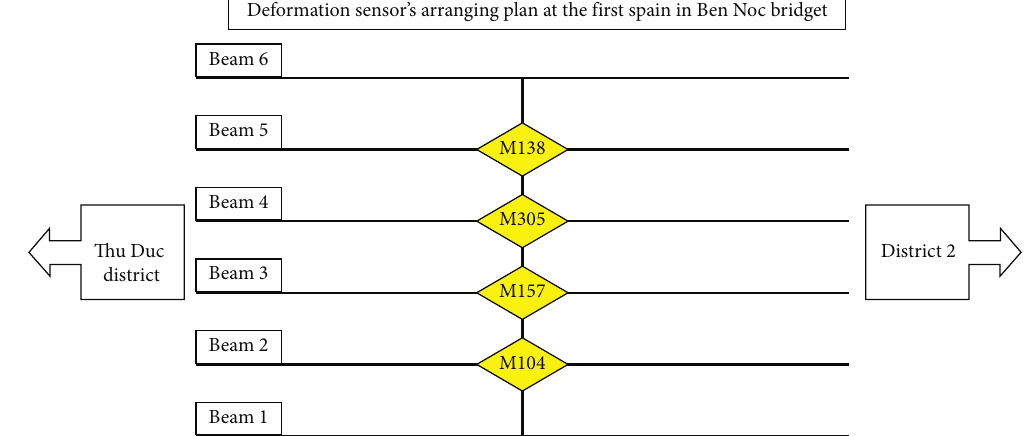
Figure 10: Plan for arranging location of deformation measurement points at Ben Noc bridge.